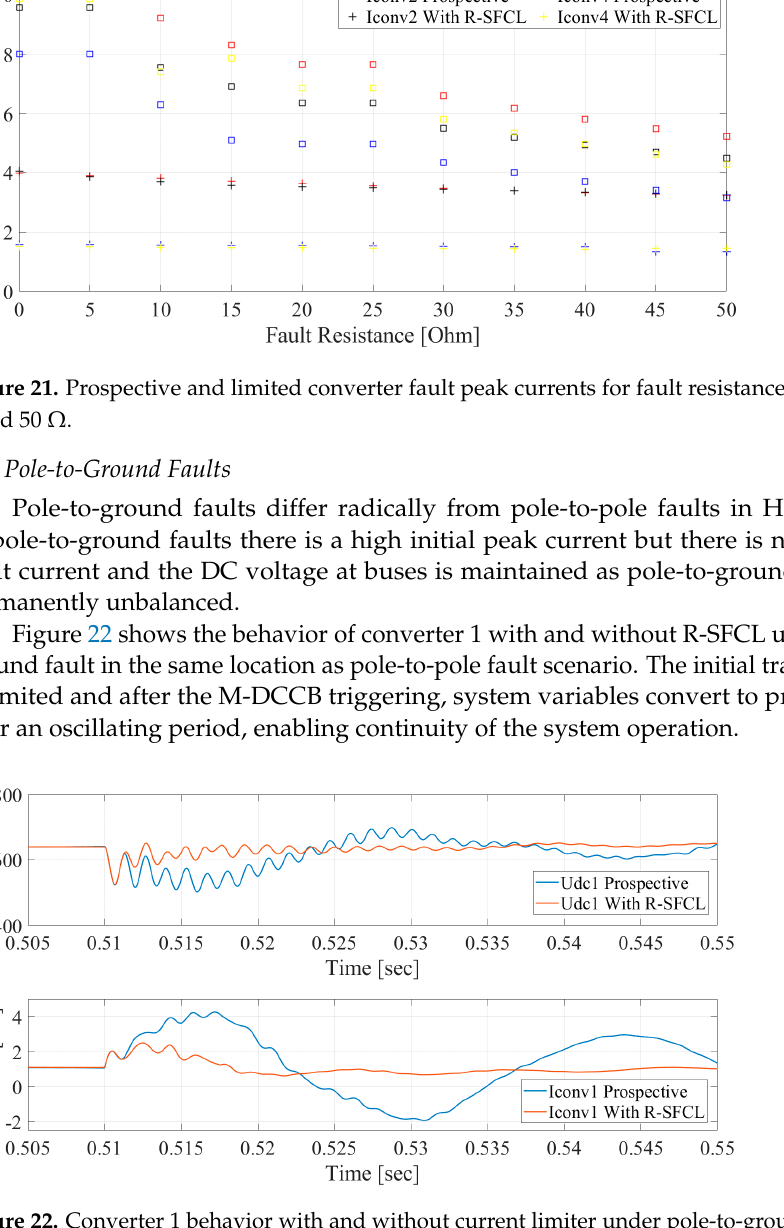
with M-DCCB and R-SFCL.